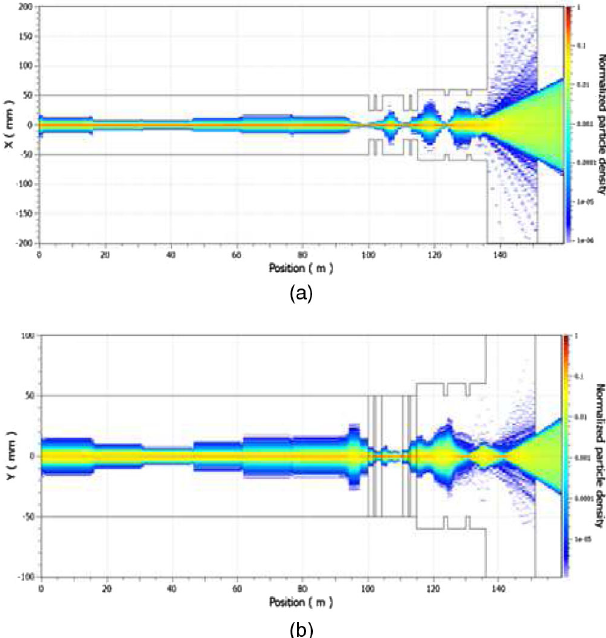
0.35FIG. 3. The normalized horizontal (a) and vertical (b) beam particle density along the HEBT. The projected beam profiles are shown on a linear scale. The vertical lines at 153 m (a),(b) represent the fixed